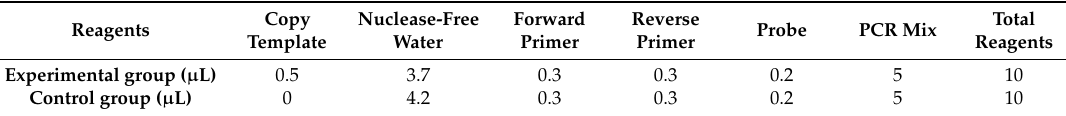
Table 1. Ratio of reaction reagents for PCR amplification.